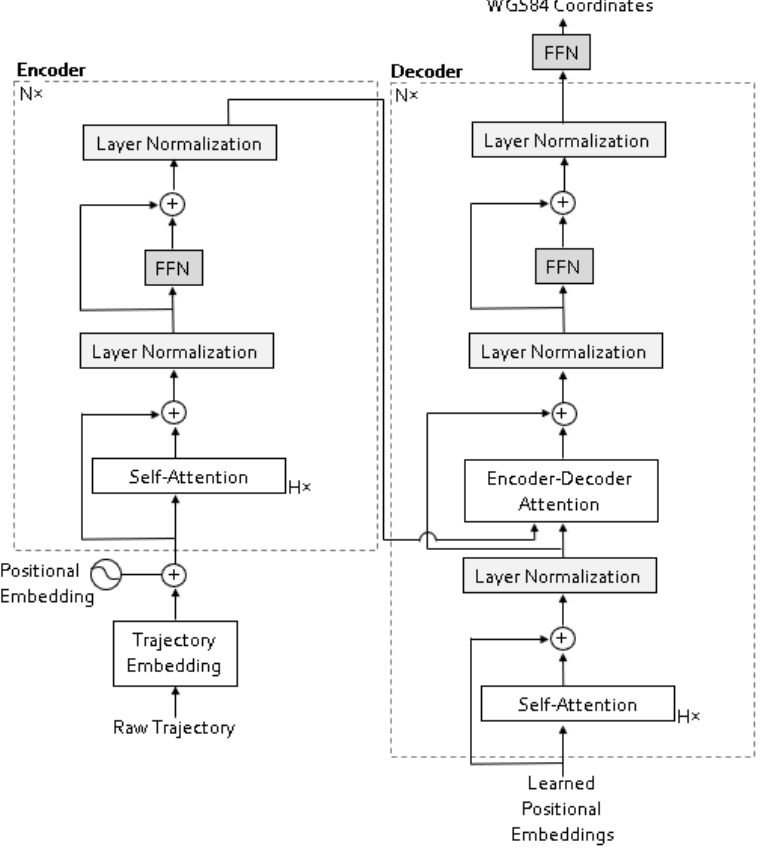
Figure 3. Architecture of transformer. Denoising of recorded GNSS coordinates.